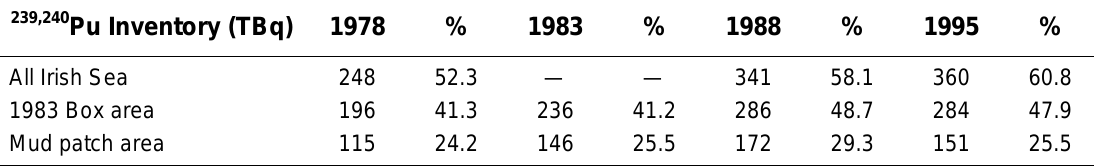
Estimated Inventories of 239,240 Pu in Designated Areas in the Subtidal Sediments of the Irish Sea, Expressed as Total Activities (TBq) and as Percentage of the Total, Inputs to the Environment – Based on Hand-Contoured Data from Field